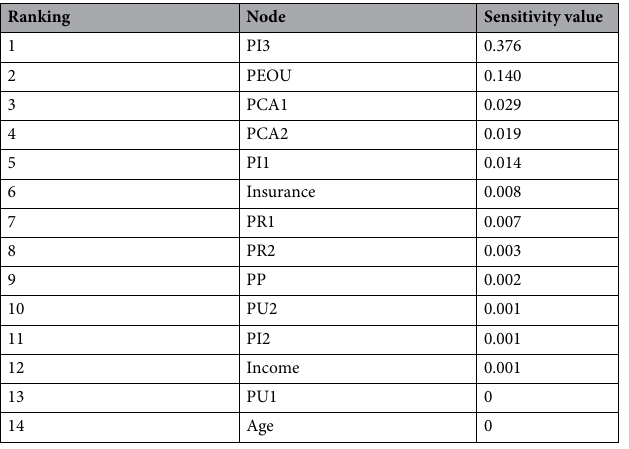
Table 4. Maximum absolute sensitivity values for the acceptability of PrEP model. PrEP pre-exposure prophylaxis, PI3 perceived image of user as health-conscious, PEOU perceived ease of use, PCA1 perceived comparative advantage over condom use, PCA2 perceived comparative advantage of having sex when the urge arises, PI1 perceived image of user as having sexual risky behavior, PR1 perceived risk of PrEP in increasing risk behavior, PR2 perceived risk of side-effects, PP perceived privacy problem, PU2 perceived utility of PrEP in reminding health awareness, PI2 perceived image of user as public-minded, PU1 perceived utility of PrEP in facilitating prevention of HIV.